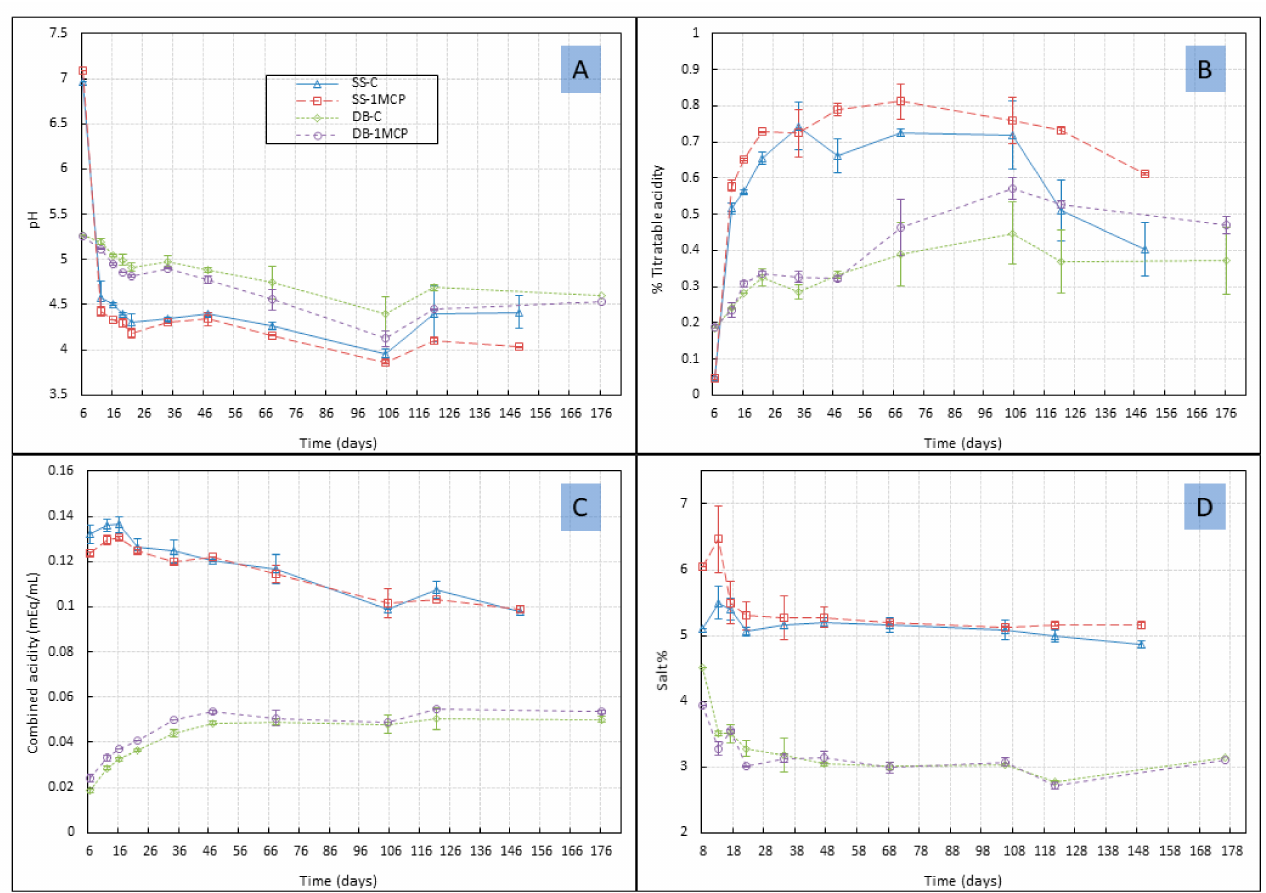
Figure 2. Evolution in the brine of pH ( A ), titratable acidity ( B ), combined acidity ( C ), and salt content ( D ) during fermentation in the different treatments assayed in this work. DB-C: control directly brined olives, DB-1MCP: directly brined olives treated with 1-MCP, SS-C: control Spanish-style olives, SS-1MCP: Spanish style olives treated with 1-MCP. Time 0 corresponds to the moment just after putting the fruits in brine fermentation. Non-overlapping error bars stand for significant differences among treatments according to ANOVA analysis and post hoc statistical LSD test using p ≤ 0.05 as the cut-off level of